Question: What style of plot is this figure drawn as?
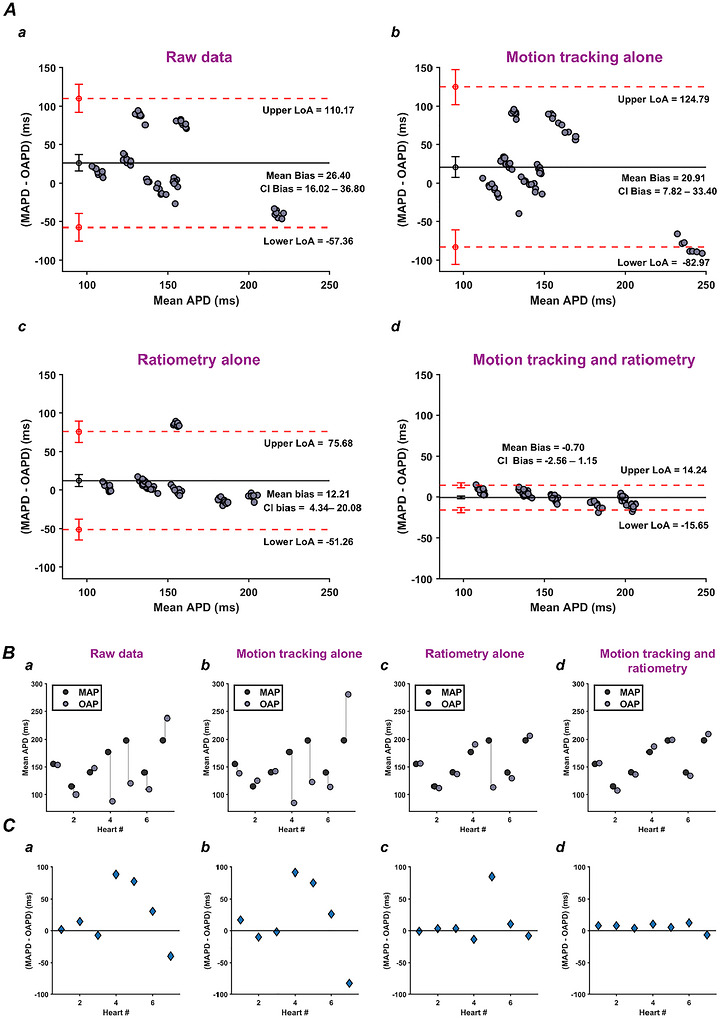
Answer: bar